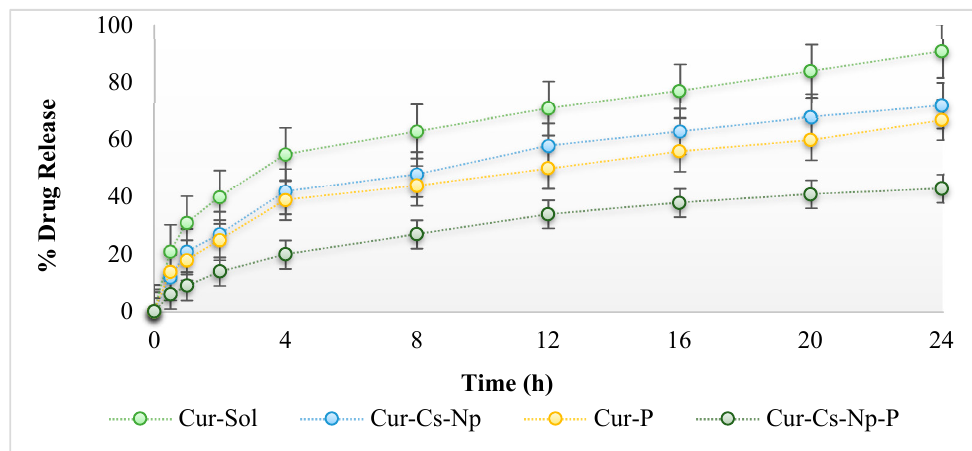
Figure 3. In-vitro release profile of curcumin. Note: Cur-Sol (curcumin solution), Cur-Cs-Np (cur- cumin chitosan nanoparticles), Cur-P (Curcumin patch), Cur-Cs-Np-P (curcumin chitosan nano- particle patch).